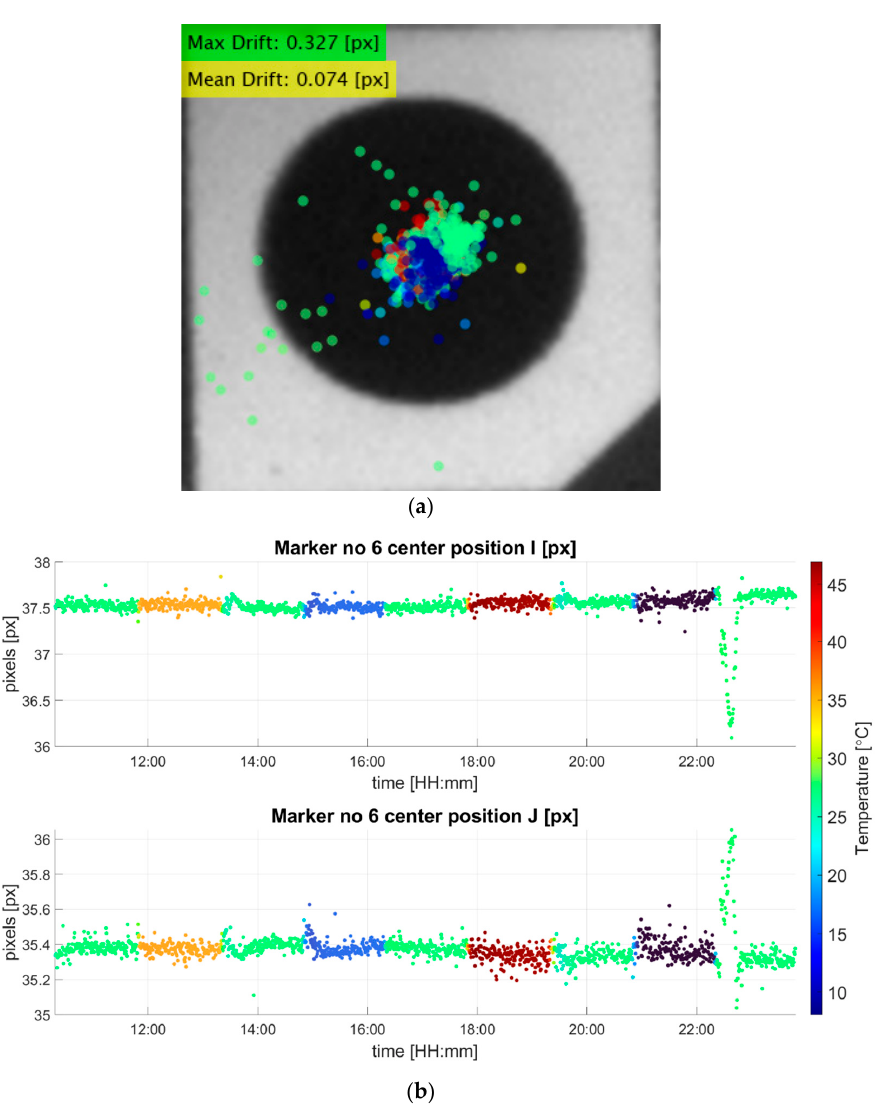
Figure 7. ( a ) The registered center drift of marker 6 (the rightmost of the four markers on the camera stage). The presented maximum and the average drift distance were obtained after excluding the